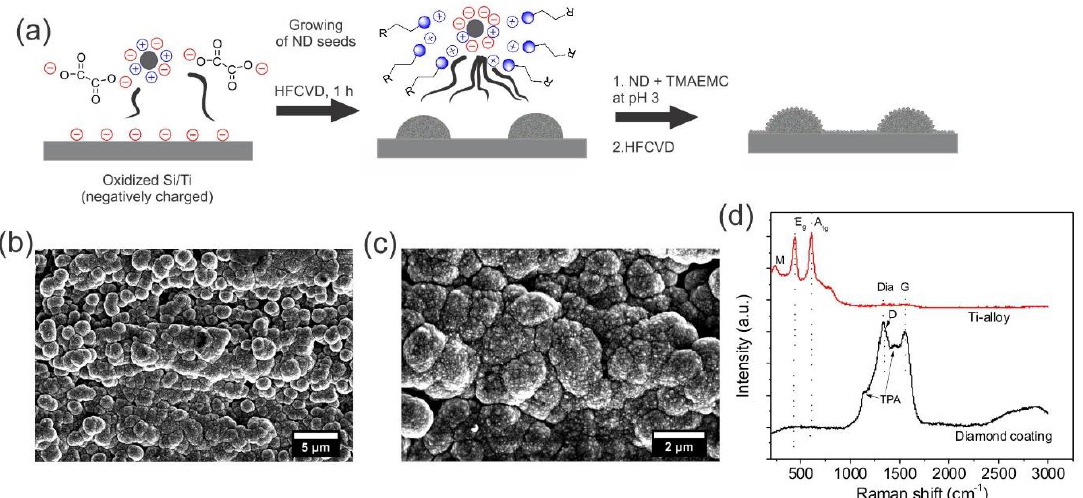
Figure 1. ( a ) Synthesis strategy of the as rough diamond surface via two successive seeding and growth cycles. SEM micrographs of the as-made rough diamond coating on Ti alloy ( b ) and its magnification ( c ). ( d ) Raman spectrum of the diamond coating from ( b ) and ( c ). Here, E g and A 1g denote the symmetry of the Raman active modes, M denotes a multi phono process, Dia is the peak for natural diamond, D and G are the D and G band of graphite, and trans-polyacetylene (t-PA) denotes the ω 1 and ω 3 vibration modes of trans-polyacetylene.